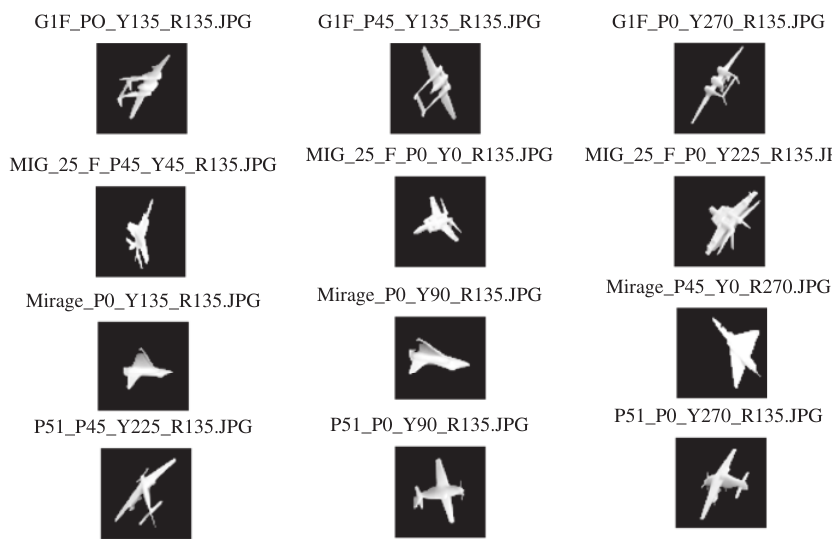
Figure 3: Segmented Test Images.